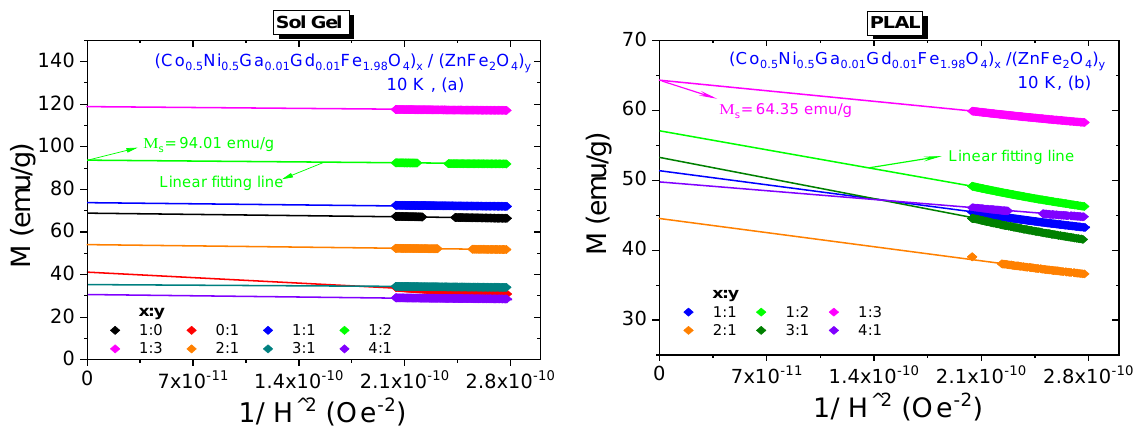
Figure 10. M vs. 1/ H 2 plots for (Co 0.5 Ni 0.5 Ga 0.01 Gd 0.01 Fe 1.98 O 4 ) x /ZnFe 2 O 4 ) y NCs synthesized by ( a ) sol-gel method and ( b ) PLAL method, 10 K. Table 3. 10 K magnetic parameters (Co 0.5 Ni 0.5 Ga 0.01 Gd 0.01 Fe 1.98 O 4 ) x /(ZnFe 2 O 4 ) y NPs synthesized by both sol-gel and PLAL.